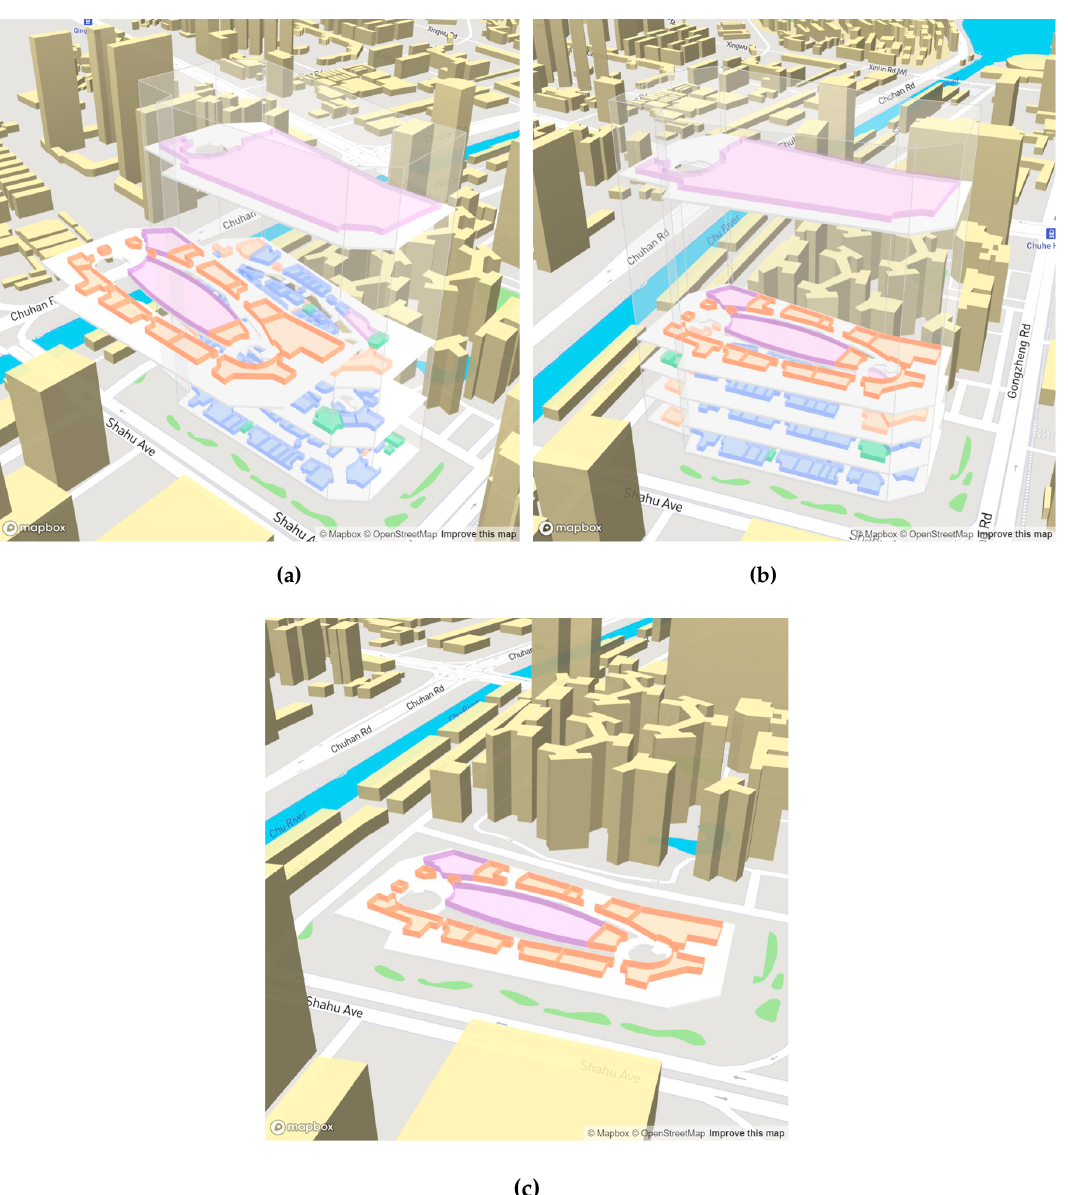
Figure 5. Multiple ways to highlight a floor: (a) changing the horizontal position of a floor; (b) changing the vertical position of a floor; (c) showing only one floor.